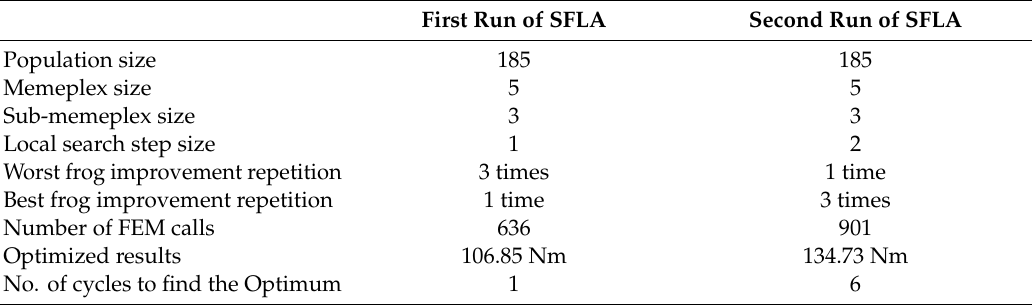
Figure 3. The conventional design of IPM used for comparison: ( a ) cross-section; and ( b ) torque plot. Table 2. Algorithm parameters used and the results obtained for two test runs of SFLA.